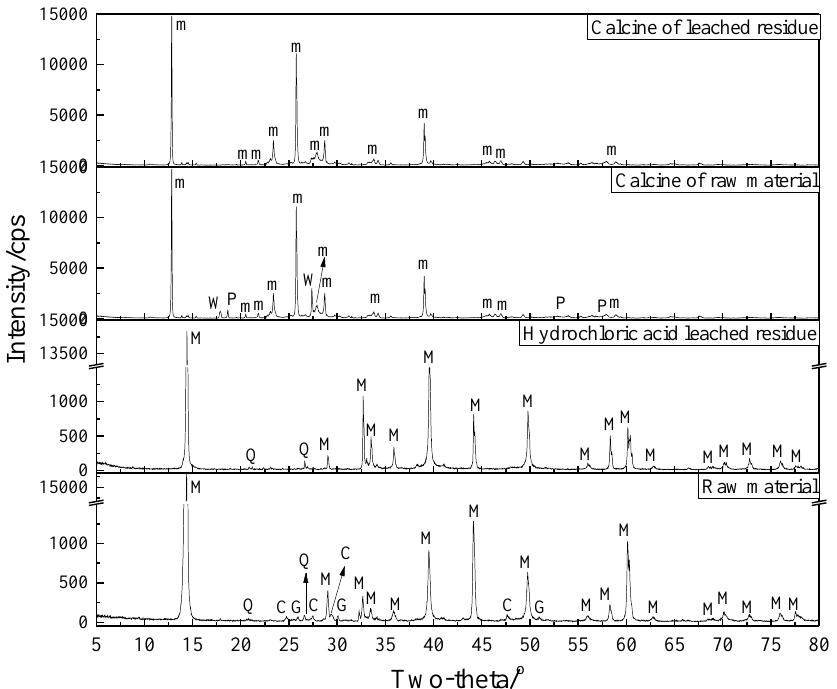
Figure 10. XRD patterns of the molybdenite concentrate and roasted products. (M—Molybdenite, MoS 2 ; G—Galena, PbS; C—Calcite, CaCO 3 ; Q—Quartz, SiO 2 ; m—Molybdite, MoO 3 ; P—Powellite, CaMoO 4 ; W—Wulfenite, PbMoO 4 ).